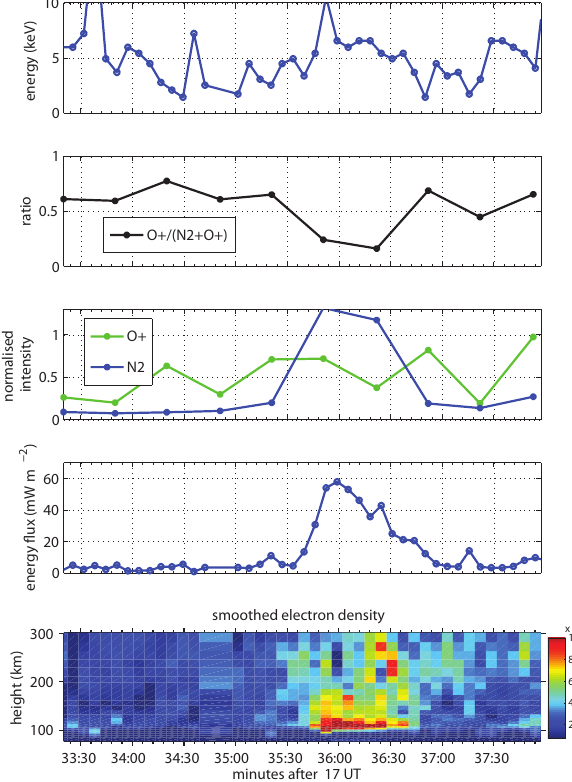
Fig. 5. Electron transport model results compared with optical re- sults: Panel 1: peak electron energy for event 1, when assuming the input electron spectrum at the top of the ionosphere to be monoen- ergetic, Panel 2: O + /(O + + N 2 ) ratio, Panel 3: O + intensity (green) and N 2 intensity (blue), Panel 4: fitted energy flux below 150km, Panel 5: Smoothed electron density height